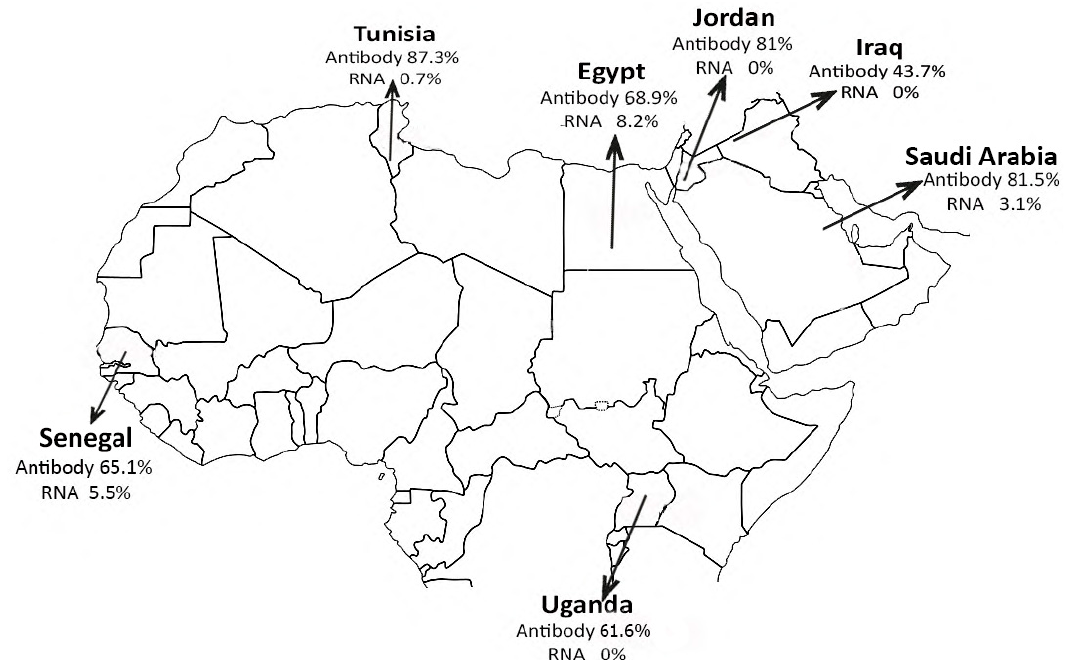
Figure 1. Countries involved in this study. Results are indicated for each country as percentage of detected virus (RNA) and seropositive rate (Antibody) for Middle East respiratory syndrome coronavirus (MERS-CoV). Maps adapted from http://d-maps.com/index.php.